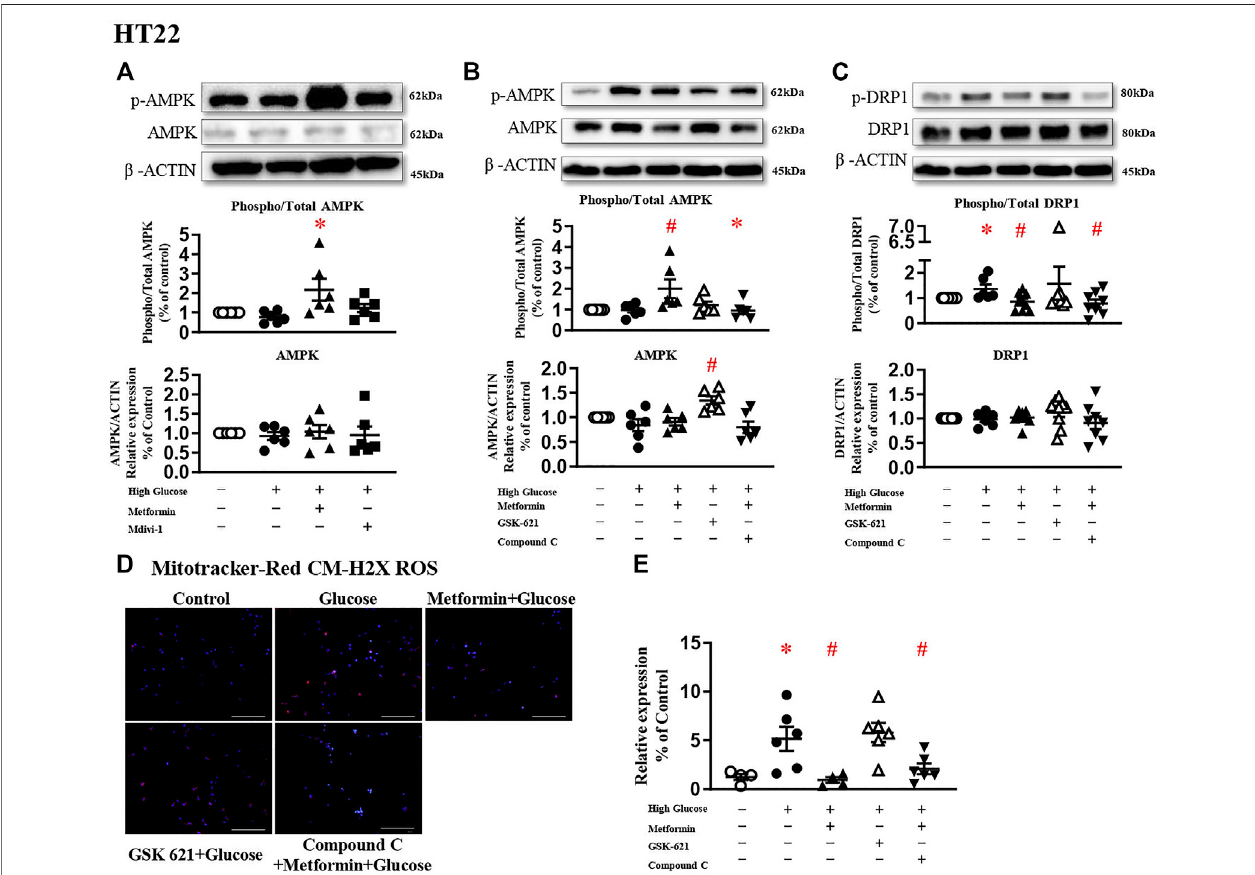
FIGURE 4| The protective effectof metformin is attributed to DRP1 phosphorylation but not AMPK activation inHT22. (A) Representative blots and densitometric quanti fi cationofAMPKproteininHT22stimulatedhighglucoseinthetreatmentofmetforminorMdivi-1.ThephosphorylationofAMPK(topblots)wasnormalizedtototal AMPKprotein(middle),andtotalAMPKwasnormalizedto β -ACTIN(bottom). (B) Representativeblotsanddensitometricquanti fi cationofAMPKproteininHT22treated with AMPK agonist GSK 621 in the absence of metformin, or AMPK antagonist Compound C in the presence of metformin. The phosphorylation of AMPK (top blots) wasnormalized tototal AMPK protein (middle), and total AMPK wasnormalized to β -ACTIN (bottom). (C) Representative blots and densitometric quanti fi cation of DRP1 protein in HT22 AMPK agonist GSK 621 in the absence of metformin, or AMPK antagonist Compound C in the presence of metformin. The phosphorylation of DRP1 (top blots) was normalized to total DRP1 protein (middle), and total DRP1 was normalized to β -ACTIN (bottom). Fluorescent signals of Mitotracker-Red CM-H2X ROS (D) (200×,Bar=800 µm)andquanti fi cation (E) inHT22proteininHT22AMPKagonistGSK621intheabsenceofmetformin,orAMPKantagonistCompoundCin the presence of metformin. Data presented as means ± SEM, * p < 0.05 vs cells under control condition, # p < 0.05 vs cells stimulated with high glucose by One-way ANOVA.